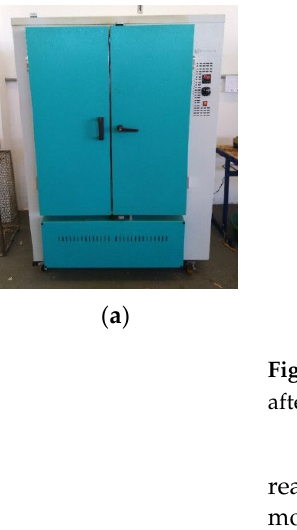
( h ) Figure 2. OSB manufacturing: ( a ) gluing, ( b ) strands already with adhesive, ( c ) particle router, ( d ) particle mattress, ( e ) cold pressing, ( f ) hot pressing, ( g ) post hot-pressing panel and ( h ) finished panels. 2.2.3. Heat Treatment of OSB The panels’ thermal treatment (Figure 3) was carried out in an electric oven without atmosphere replacement at two different temperatures (i.e., 175 °C and 200 °C) depending on the treatment, which were defined based on the evaluation of the thermal degradation kinetics of the materials. The panels were placed inside the oven turned off and separated by wooden slats in order to allow the circulation of warm air between them. After accommodating the panels, the oven was closed and turned on, and when it reached the desired temperature inside, the panels were kept there for 60 min for thermorectification. The heat treatment time was defined after the tests for thermal degradation kinetics of the materials did not show degradation of wood and resin for the evaluated temperatures (i.e., 175° for T3 and T4 and 200° for T5 and T6 panels) for up to 60 min, the time also adopted for heat treatment in the study by Silva et al. [27]. The heating process for thermal grinding to a temperature of 175 °C took approximately 65